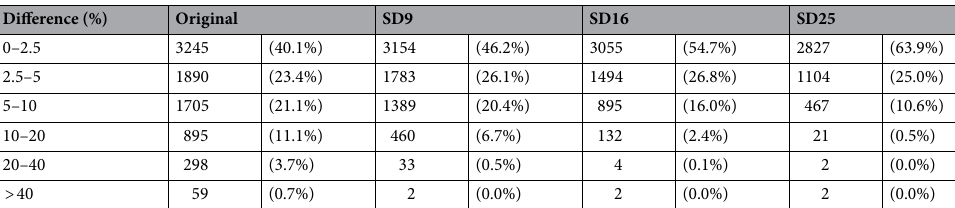
Table 1. Sensitivity analysis of surface of municipalities to different areal thresholds in dissolve operation. Municipalities are grouped in four bins by differences in their area as represented in the original vector layer and in the rasterized versions (0–2.5%; 2.5–5%; 5–10%; 10–20%; 20–40% and > 40% difference). The area of municipalities rasterized at 0.01 degrees using the original vector layer (Original) is compared with